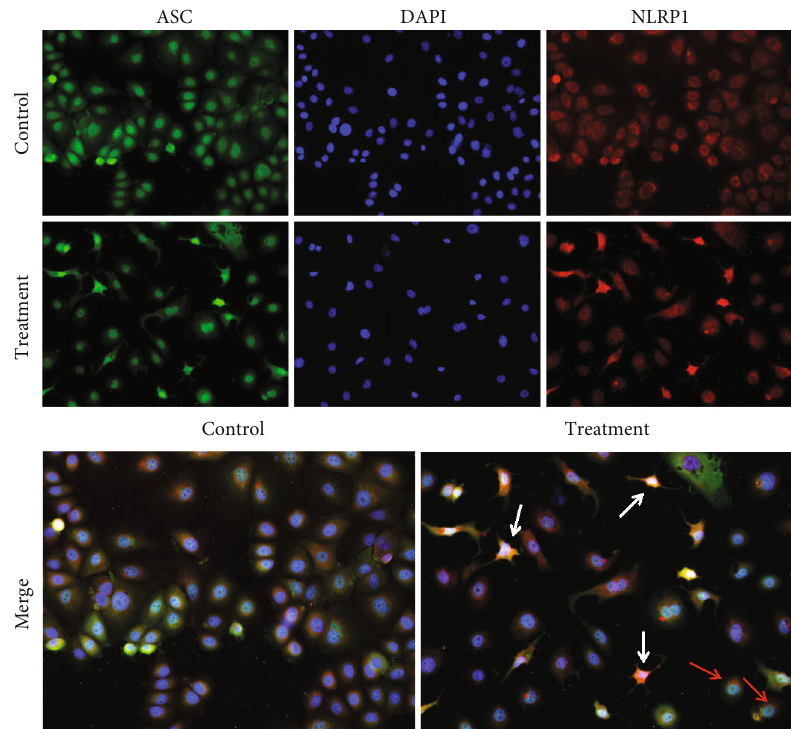
Figure 2: The immuno fl uorescence images of ASC specks. Representative micrographs from at least three independent experiments are shown. All images were taken using 20x magni fi